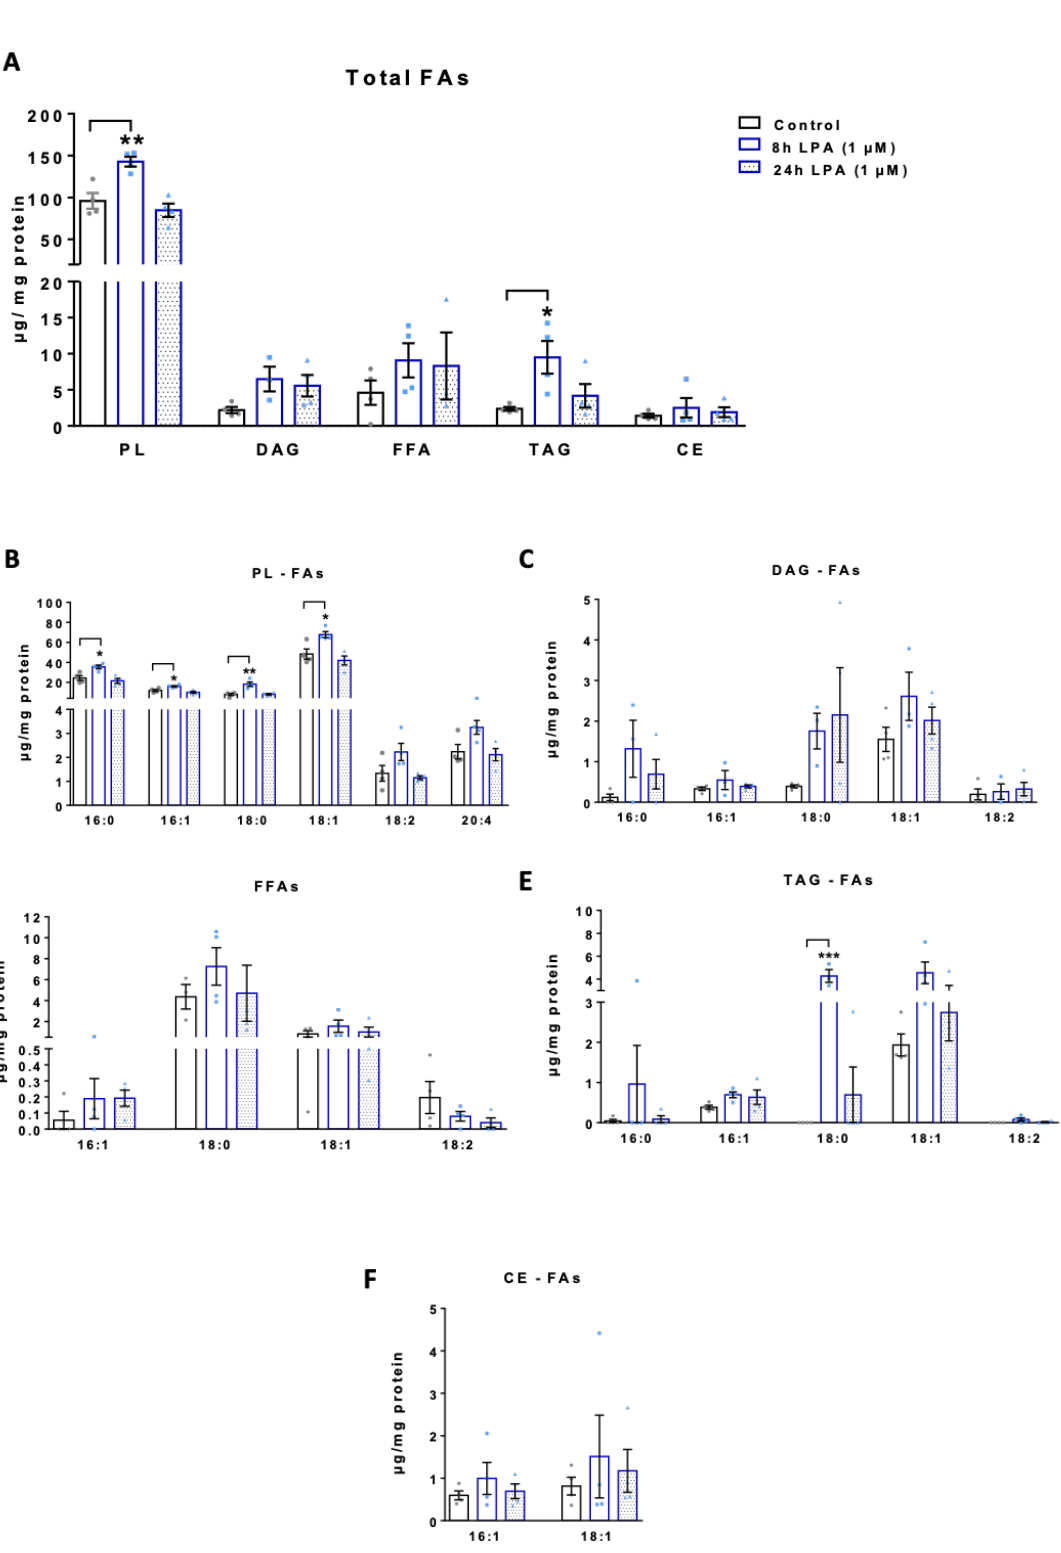
Figure 5. Quantitation of fatty acid species in lipid subclasses of LPA treated BV-2 cells. Serum starved BV-2 cells were incubated in the absence and presence of 1 µM LPA for the indicated times. ( A ) Quantitation of total FAs present in the indicated lipid species (PL, phospholipids; DG, diacylglycerols; FFA, free fatty acids; TAG, triacylglycerols; CE, cholesterylesters). Individual FA content in each lipid class: ( B ) Phospholipids, ( C ) diacylglycerols, ( D ) free fatty acids, ( E ) triacylglycerols, and ( F ) cholesterylesters. Data represent mean ± SEM of four independent experiments; * p < 0.05, ** p < 0.01, *** p < 0.001 compared to control; one-way ANOVA with Bonferroni correction).